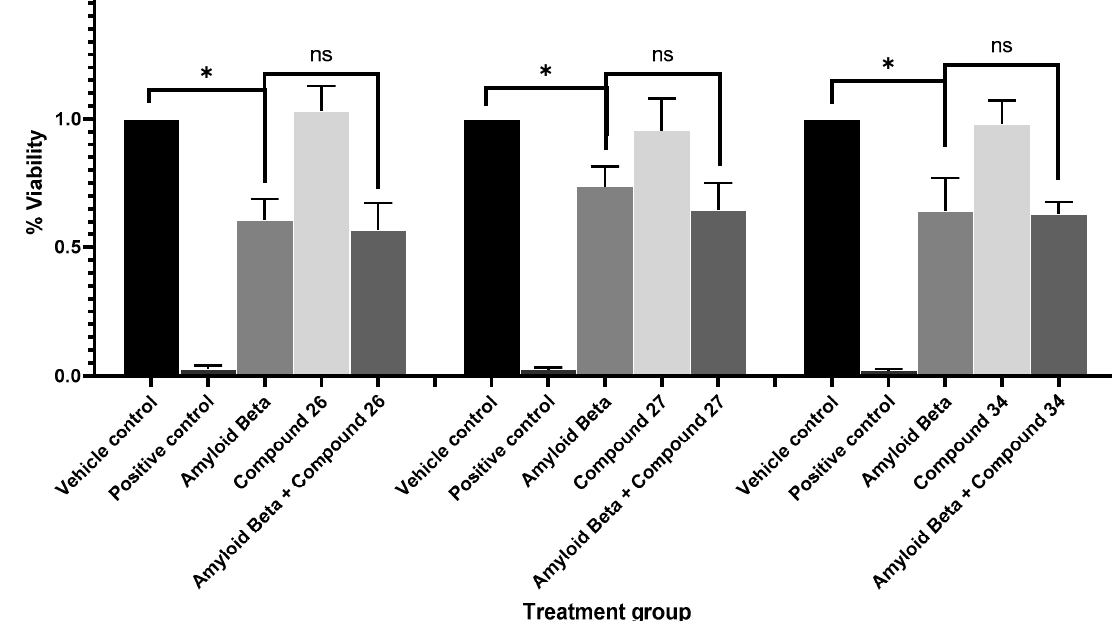
Figure 5. Amyloid beta alone significantly decreases cell viability in SH-SY5Y cells with compounds 26, 27, and 34 (at IC 50 concentrations), providing no significant neuroprotection. Cell viability was measured as an MTT reduction, and data ± SEM (n = 3) were normalized as % vehicle control (black column). Asterisk (*) indicates significant difference from vehicle controls as determined by one-way ANOVA followed by Tukey’s post hoc test ( p < 0.05); ns, not significant.